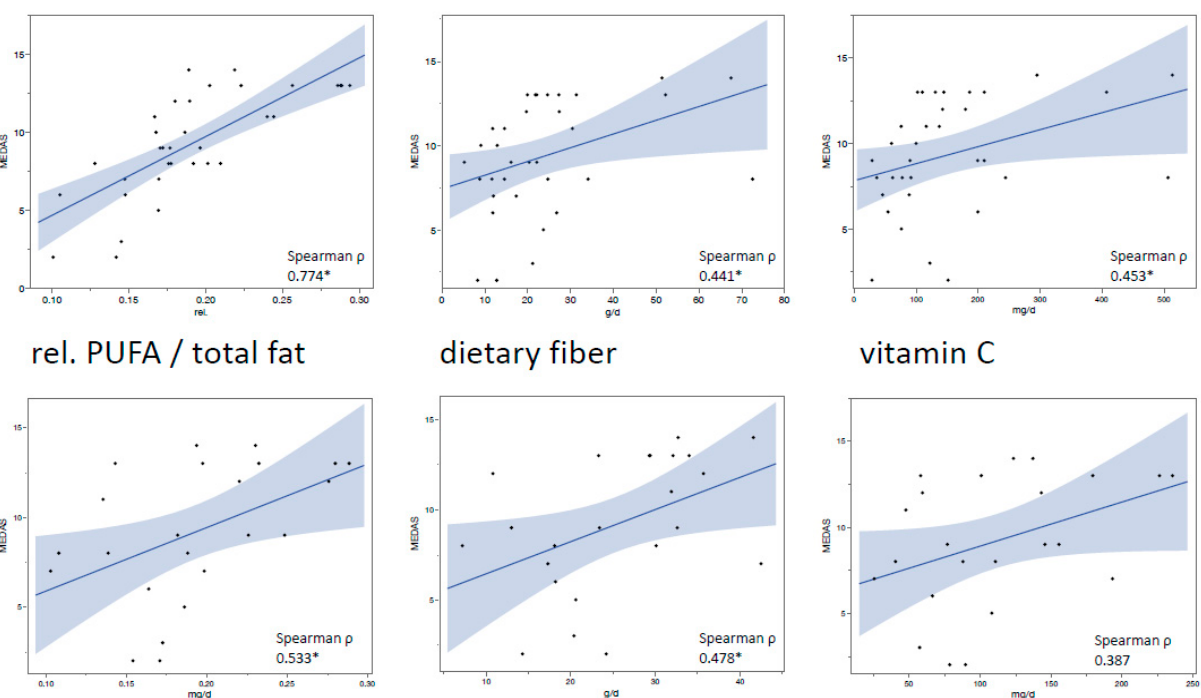
Figure 4. Correlations between the MEDAS score and MedD-associated nutrients. Scatterplots with regression lines and 95% confidence intervals; data from T 2 for both groups (FFQ, n = 36; 24dr, n = 23). * p < 0.05, MEDAS = Mediterranean Diet Adherence Screener, PUFA = polyunsaturated fatty acids.